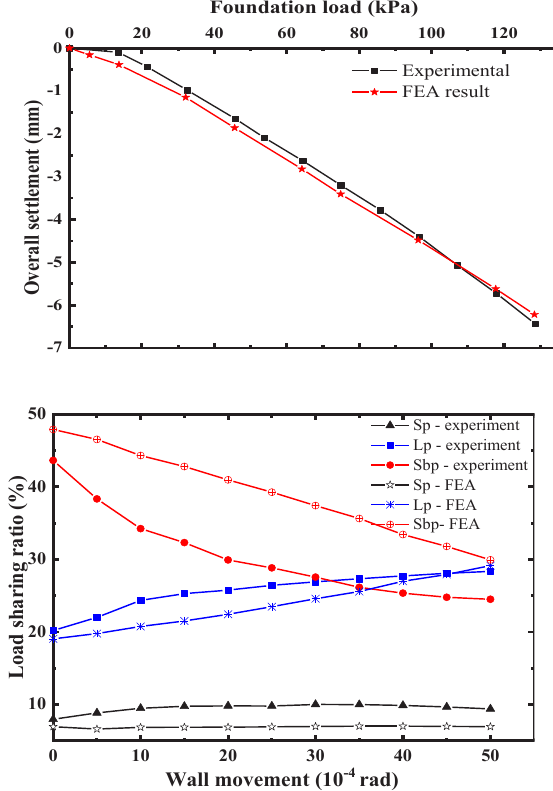
Figure 4: Comparison of experimental (a) load settlement curve and (b) load-sharing ratio during wall rotation with finite element analysis result (Lp - long pile, Sp - short pile, Sbp - soil between piles).